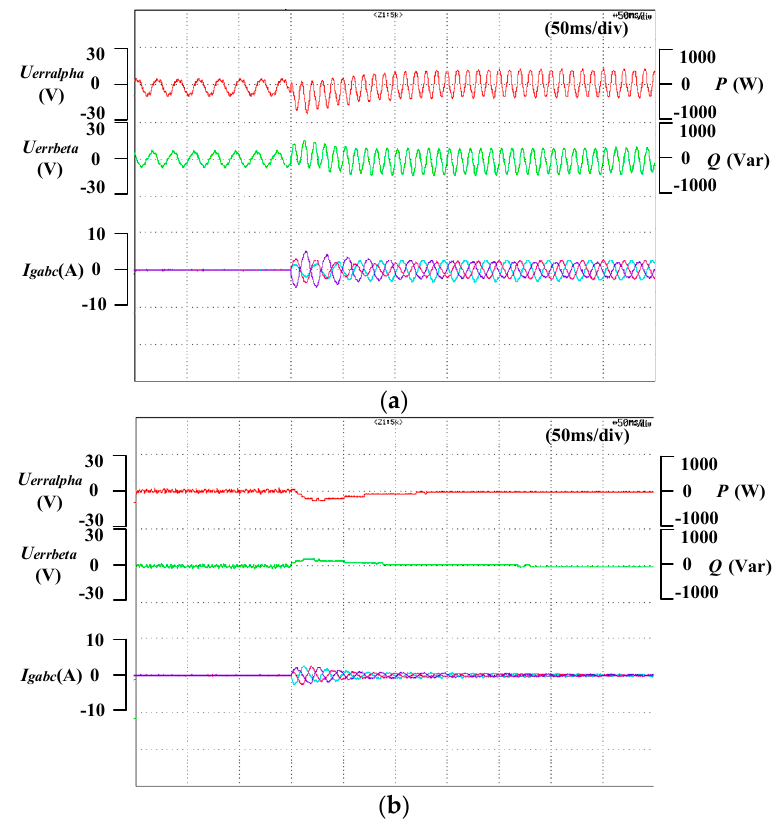
Figure 9. The experimental platform.